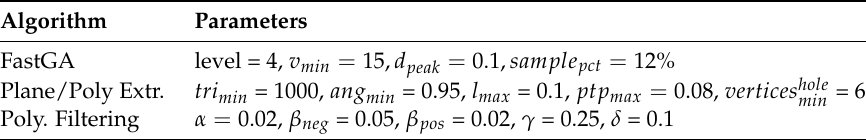
Table 15. Polylidar3D Parameters for the Main Floor